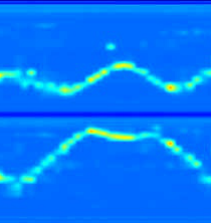
Figure 2. An example of single-cycle processed heatmap. The upper part is the ordinate change curve, and the below part is the abscissa change